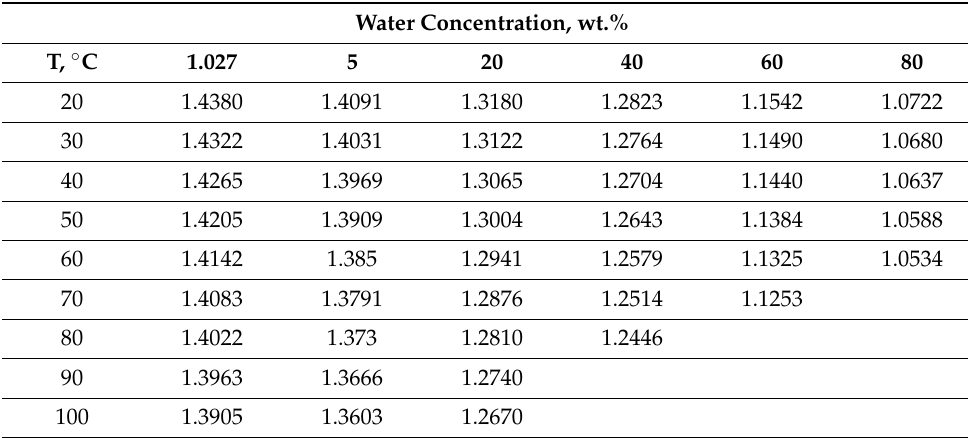
Table 4. Density of AEPA-Gl aqueous solutions, g/cm 3